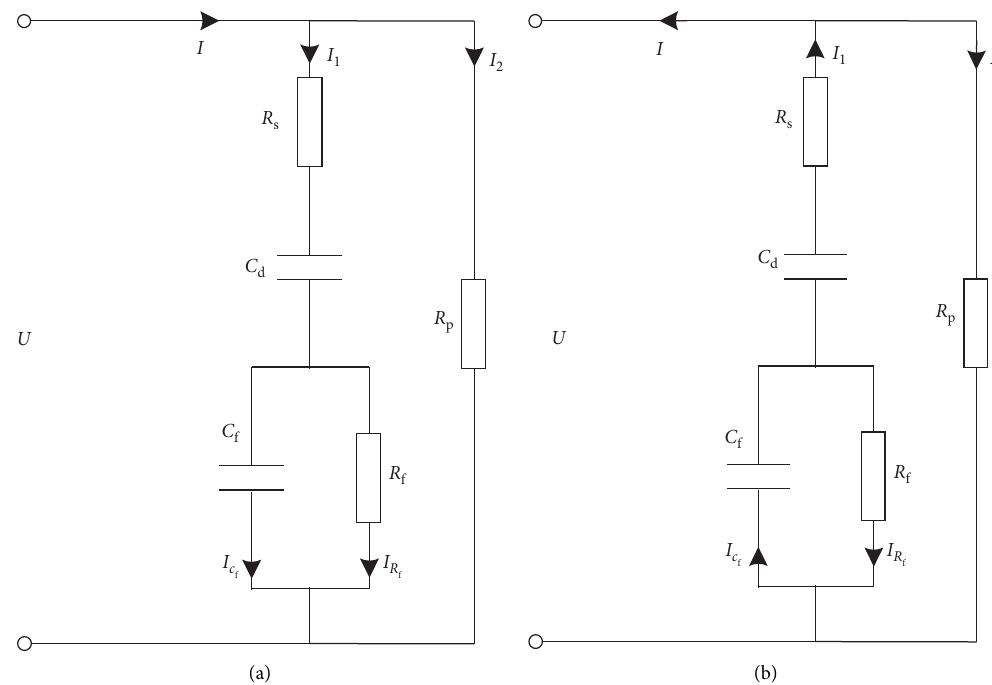
Figure 7: Charge-discharge current flow diagram of the supercapacitor model. (a) The supercapacitor model in charge process; (b) the supercapacitor model in discharge